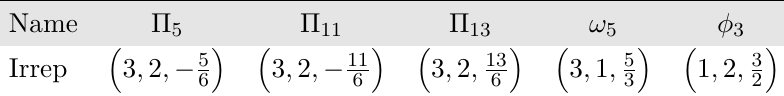
Table 6. New scalars.